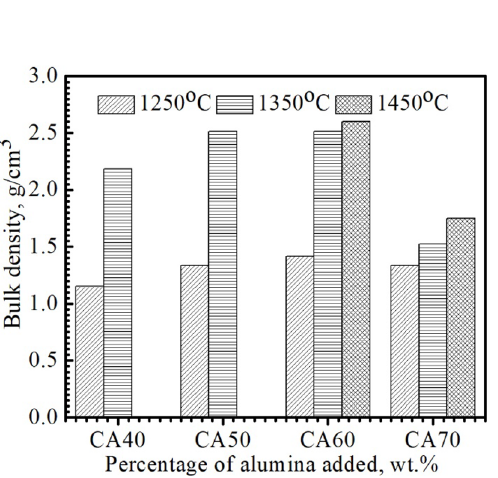
Figure 4. Apparent porosity of the compacted specimens sintered at 1250, 1350 °C and 1450 °C.